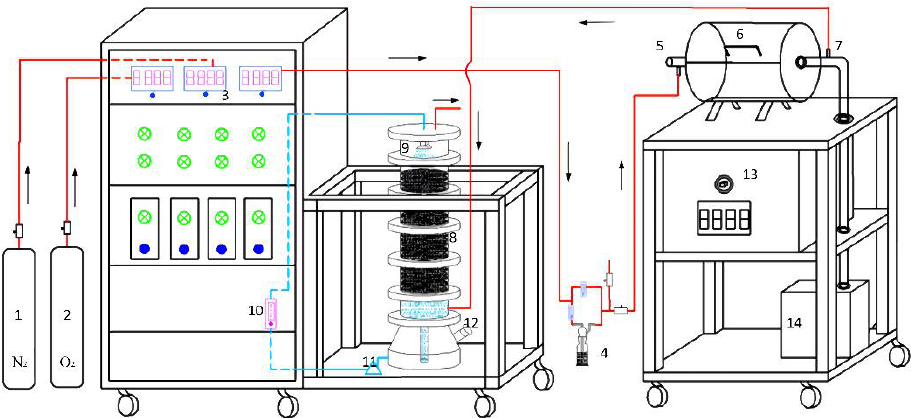
Figure 1. Integrated device of low temperature plasma biological BTF. 1. N 2 ; 2. O 2 ; 3. Gas flowmeter; 4. VOC generator; 5. Inlet of gas; 6. Safety device; 7. Outlet of gas; 8. Biotrickling filter; 9. Spray; 10. Liquid flowmeter; 11. Pump; 12. Liquid replacement; 13. Control panel on plasma reactor; 14. Power supply for plasma reactor.